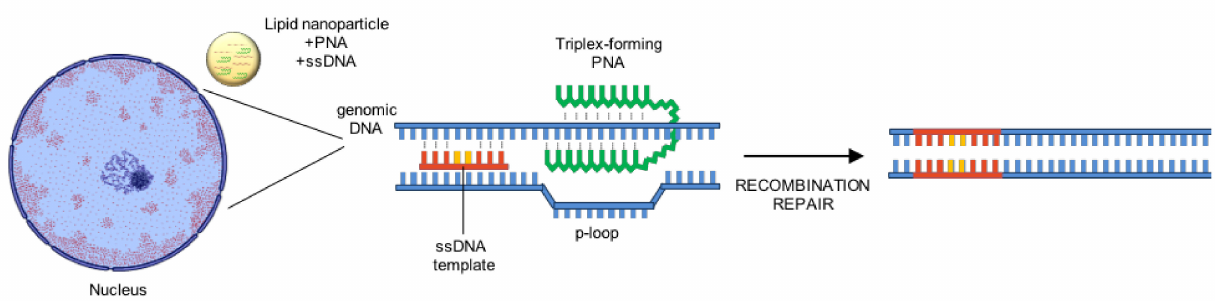
Figure 2. DSB-free insertion of genomic edits using PNAs. Lipid nanoparticle have been used to deliver PNA and single strand DNA (ssDNA) donor templates. After strand invasion by the PNA, the p-loop is recognized by the endogenous DNA repair machinery, which induce the introduction of the desired edits carried by the ssDNA. DSB: double strand break; PNA: peptide nucleic acid; ssDNA: single-stranded